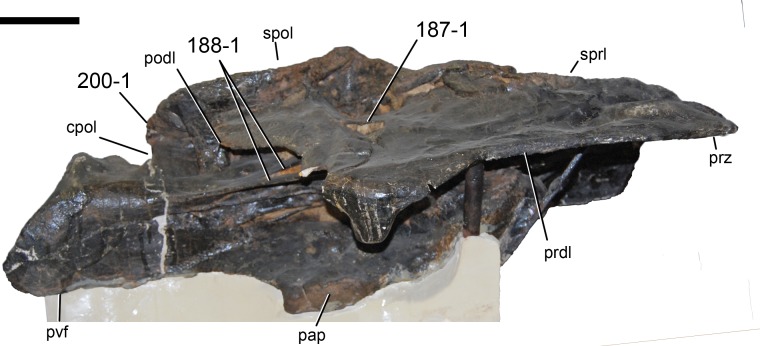
Posterior cervical vertebra of Barosaurus lentus YPM 429 in right lateral view.Note the short horizontal accessory lamina within the spinodiapophyseal fossa (C187-1), the anteriorly bifurcated posterior centrodiapophyseal lamina (C188-1), and the anteriorly restricted postzygapophyses (C200-1). Abb.: cpol, centropostzygapophyseal lamina; pap, parapophysis; podl, postzygodiapophyseal lamina; prdl, prezygodiapophyseal lamina; prz, prezygapophysis; pvf, posteroventral flanges; spol, spinopostzygapophyseal lamina; sprl, spinoprezygapophyseal lamina. Scale bar = 10 cm.